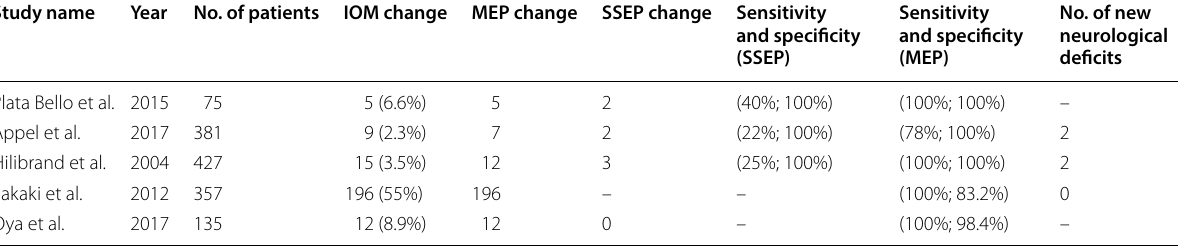
Table 3 Sensitivity and specificity of intraoperative monitoring